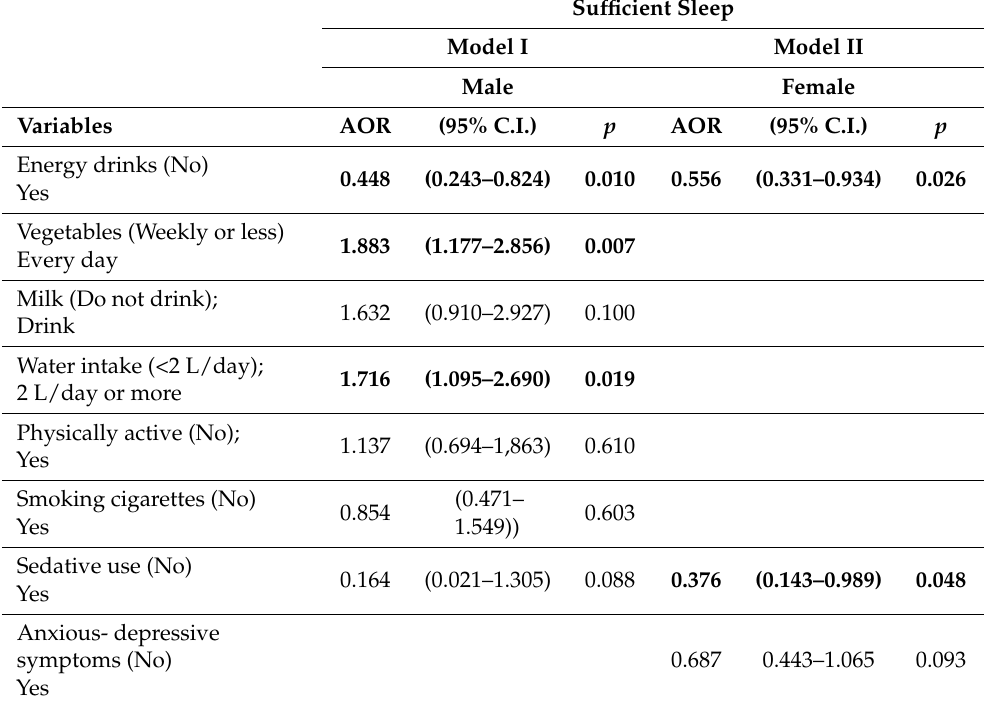
Table 3. Multivariable logistic regression models by genders ( n =